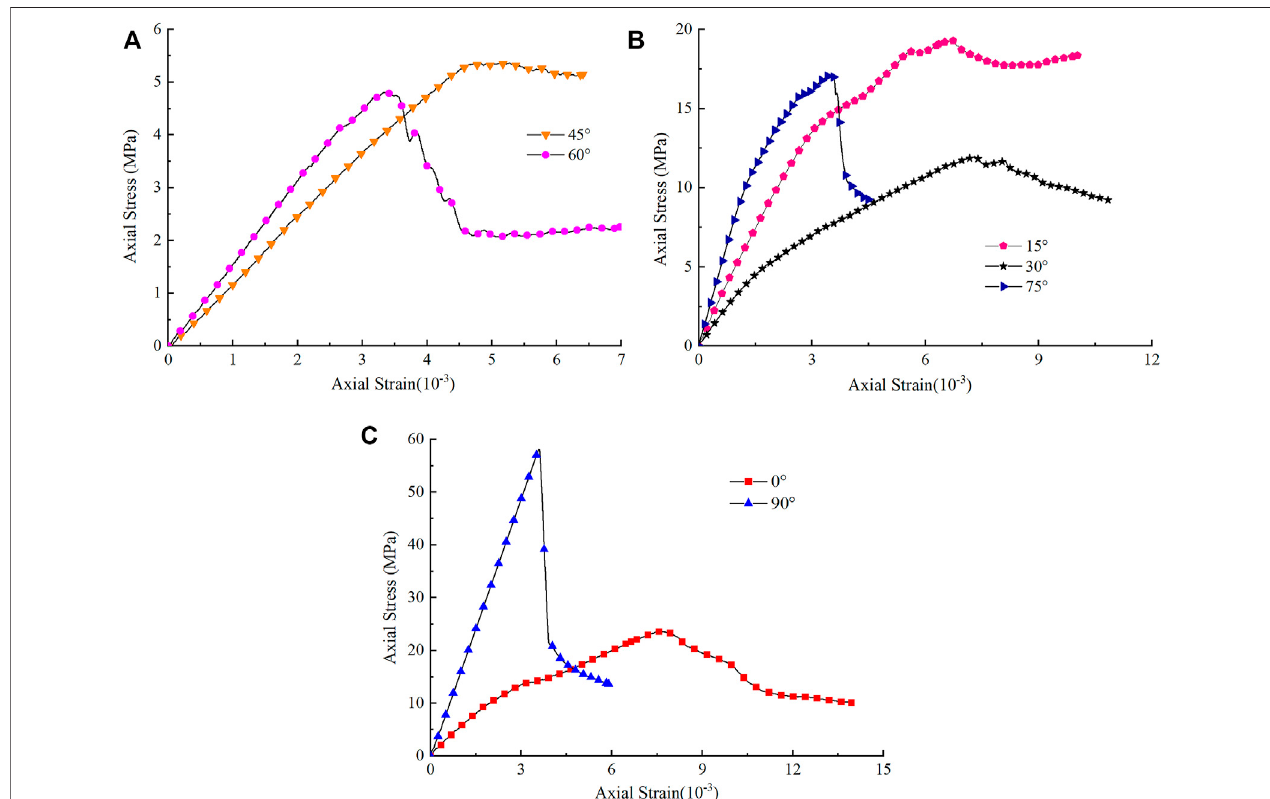
FIGURE2| Stress-straincurvesofuniaxial compression tests. Thepart labels (A-C) aretodistinguishthedifferentstress-straincurvesofCJRM withdifferentjoint angles (0 ° , 15 ° , 30 ° , 45 ° , 60 ° , 75 ° and 90 ° ).